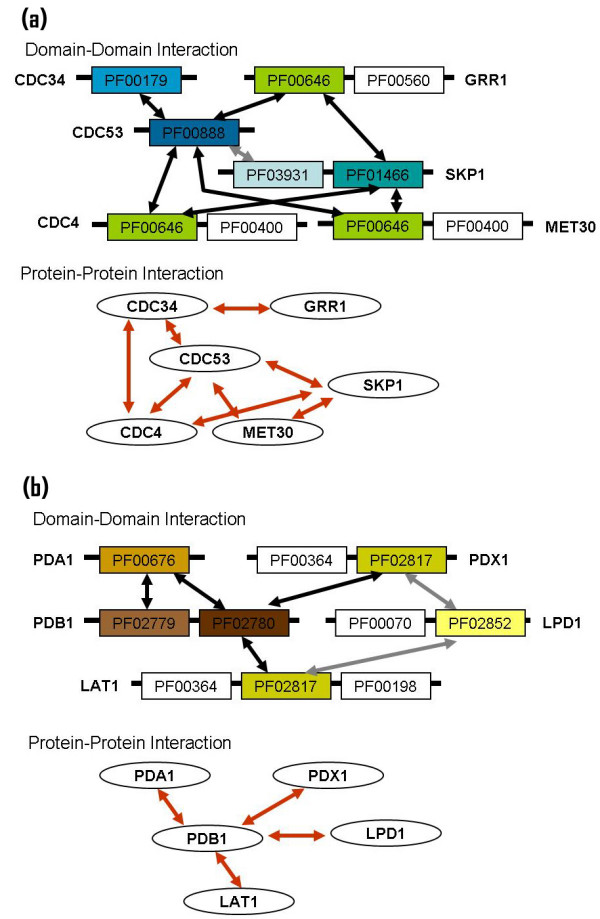
Two examples of yeast complexes with predicted domain-domain interactions and MIPS physical protein interactions. The black arrows are predicted DDIs, the grey arrows are DDIs in iPfam, and the red arrows are PPIs from DIP. (a) SCF (Skp1-Cdc53-F-box protein) complexes. Cdc53 controls G1/S transition. Cdc34 is E2 ubiquitin-conjugating enzyme. Skp1 is kinetochore protein complex Cbf3, subunit D. Cdc4, Met30, and Grr1 are the F-box proteins. (b) Pyruvate dehydrogenase complexes. Pdb1 is pyruvate dehydrogenase (lipoamide) beta chain precursor, Pda1 is pyruvate dehydrogenase (lipoamide) alpha chain precursor, Lpd1 is dihydrolipoamide dehydrogenase precursor, Pdx1 is pyruvate dehydrogenase complex protein X, and Lat1 is dihydrolipoamide S-acetyltransferase. For details, see the main text.